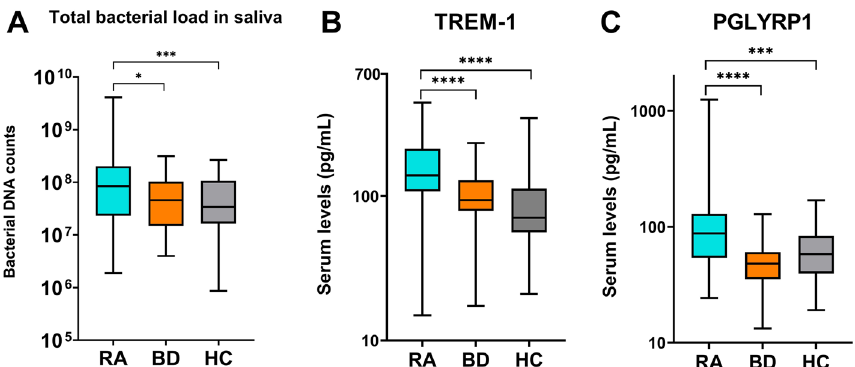
Figure 1. Comparisons among the three groups. ( A ) total bacterial DNA counts in saliva are compared between pair of groups (Mann–Whitney, p = 0.05). ( B ) serum TREM-1 levels are compared between pair of groups (Mann–Whitney, p = 0.05). ( C ) serum PGLYRP1 levels are compared between pair of groups (Mann– Whitney, p = 0.05). Boxplots show the first and third quartile (top and bottom edges of the rectangle) divided by the median. Whiskers correspond to the highest and lowest values. A base-10 log scale is applied on the y-axis. ***p ≤ 0.001, ****p ≤ 0.0001. RA rheumatoid arthritis, BD Behçet’s disease, HC healthy